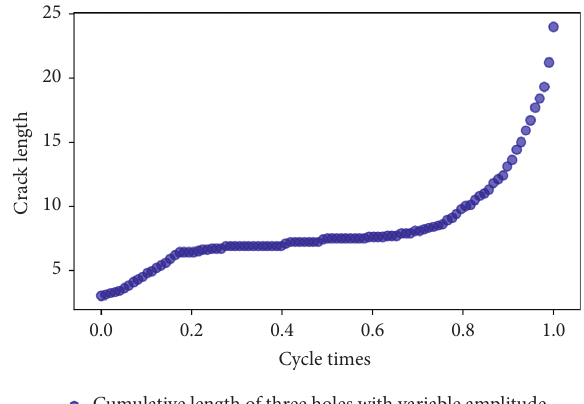
Figure 12: Cumulative length of two holes with constant